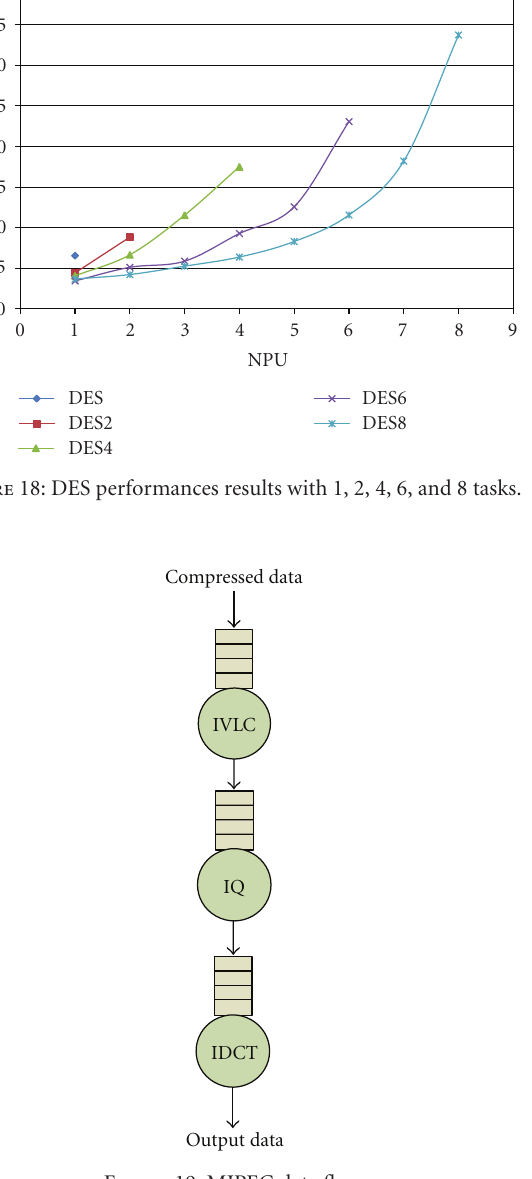
Table 6: Throughput evolution with task graph